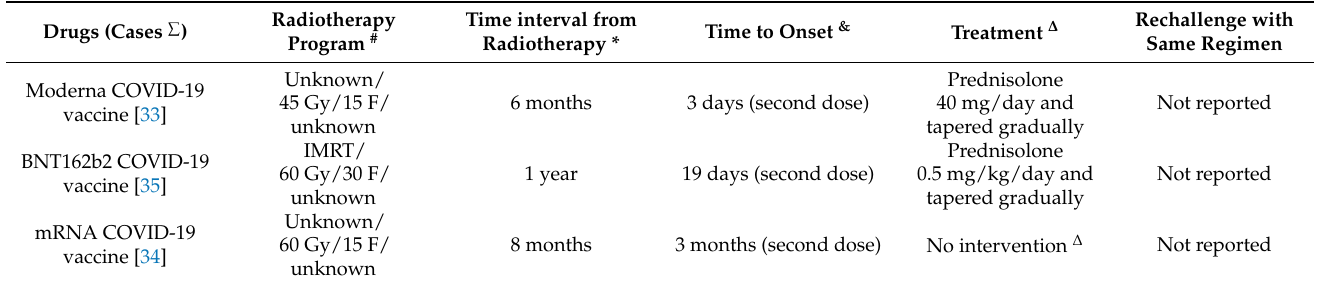
Table 4. Summary of published cases of RRP induced by